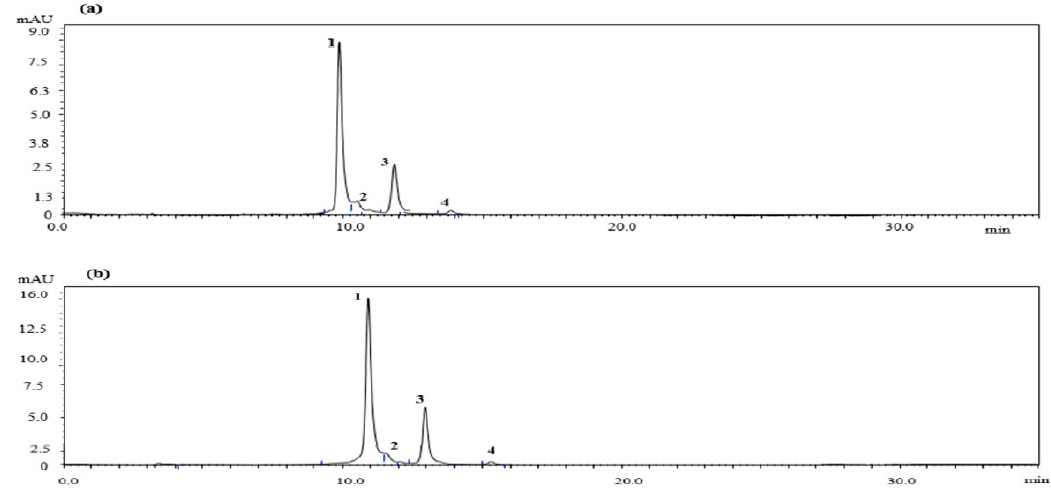
Figure 1. HPLC chromatograms of AM extracts; ( a ) AM-DW; ( b ) AM-EtOH. Peaks: (1) Cyanidin-3- galactoside; (2) Cyanidin-3-glucoside; (3) Cyanidin-3-arabinoside; (4) Cyanidin-3-xyloside. Table 1. Content of anthocyanin compounds of Aronia melanocarpa ‘Viking’ extracts. Peak